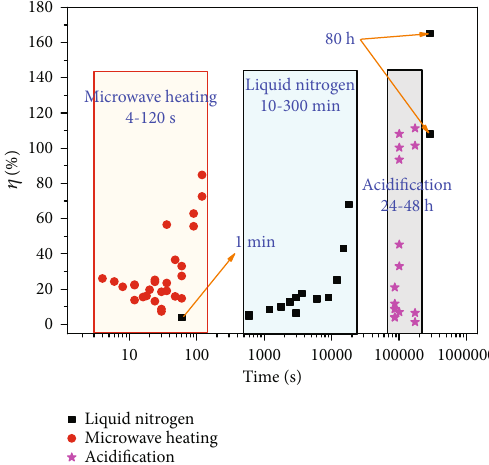
Figure 20: The relation between duration and pore change rate (the data come from the literatures [20, 72, 78, 79,86,94, 96, 123 – 127,